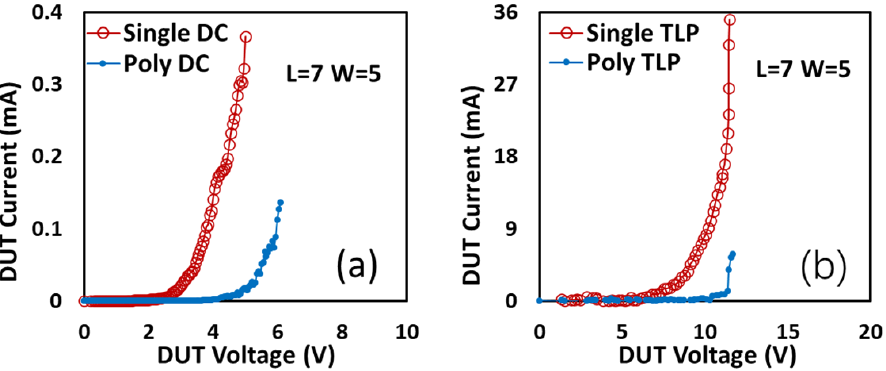
Figure 13. Comparison between single-crystalline and poly-crystalline graphene gNEMS switches: ( a ) DC sweeping I–V curves; ( b ) transient ESD I–V curves under TLP zapping.